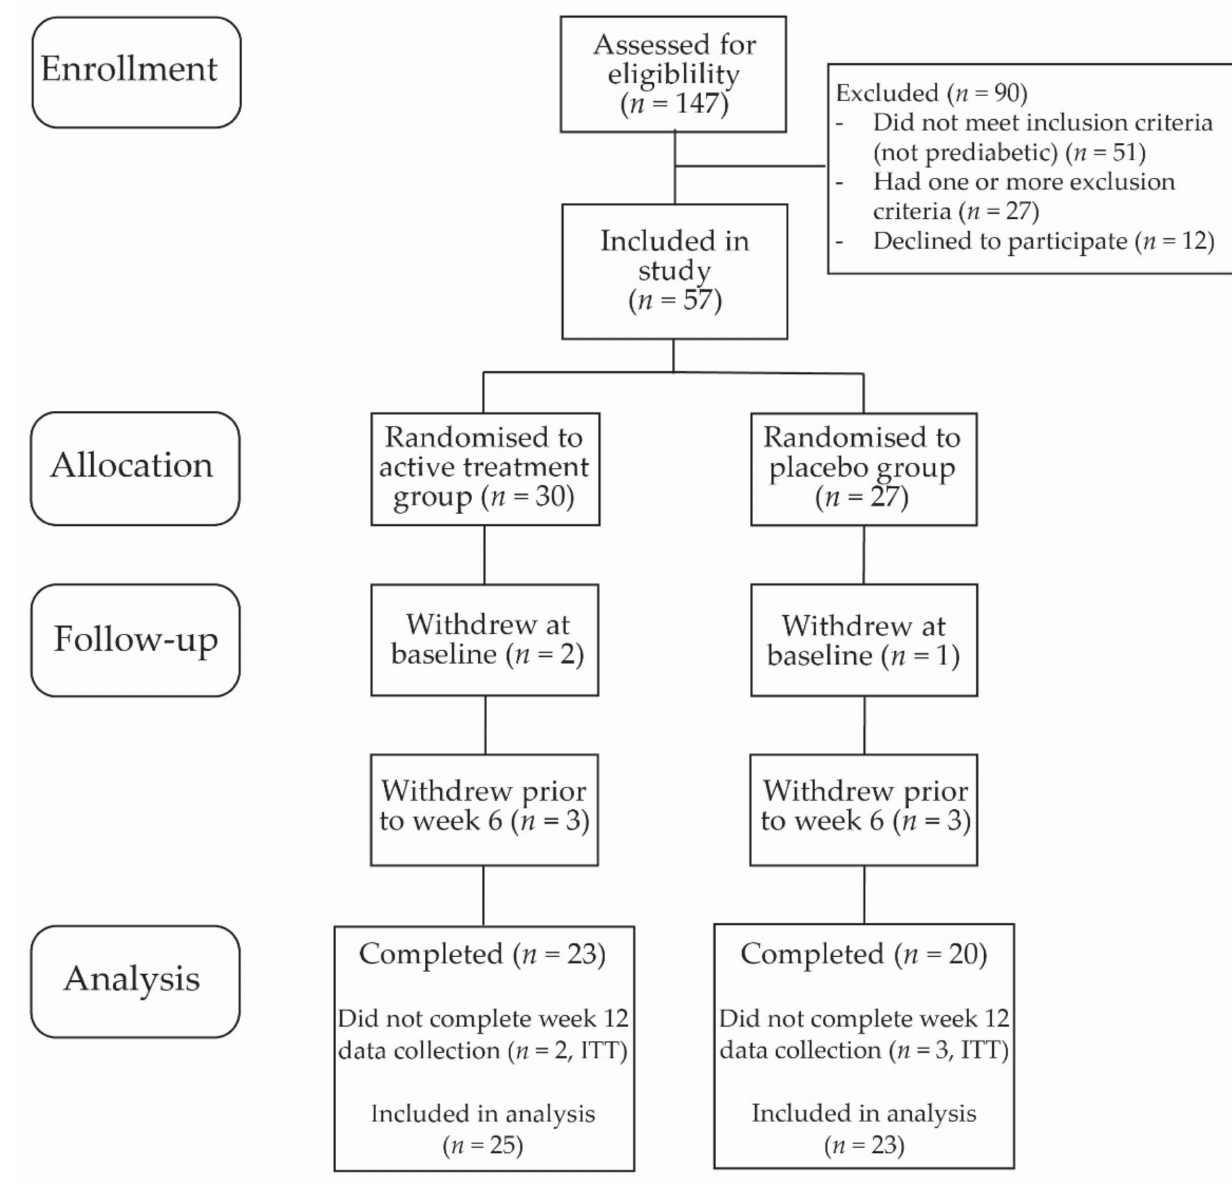
Figure 1. CONSORT participant flow